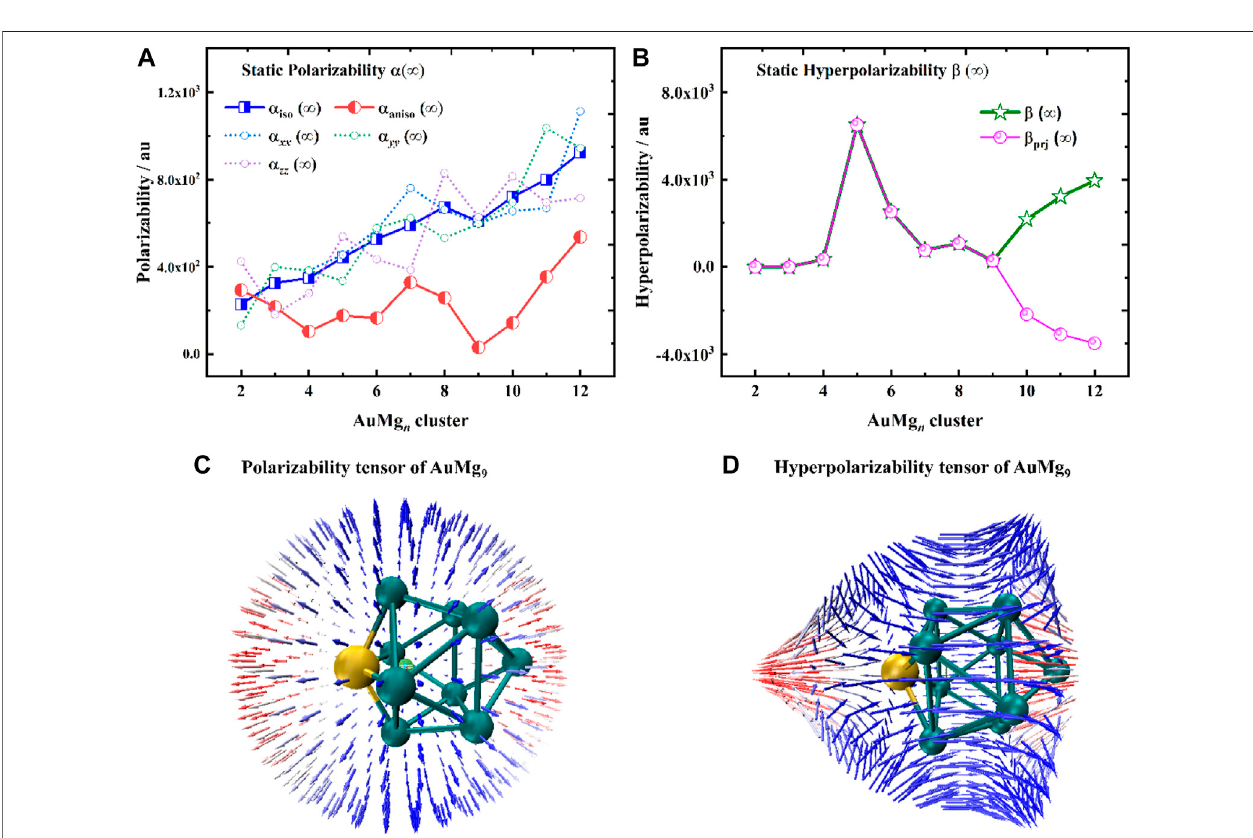
FIGURE 6 | (A) Static polarizabilities α ( ∞ ), (B) Static hyperpolarizabilities β ( ∞ ) for the ground state of AuMg n ( n = 2 – 12) nanoclusters, (C) The unit sphere representation of static polarizability tensor α , (D) The unit sphere representation of static hyperpolarizability tensor β of AuMg 9 nanocluster.